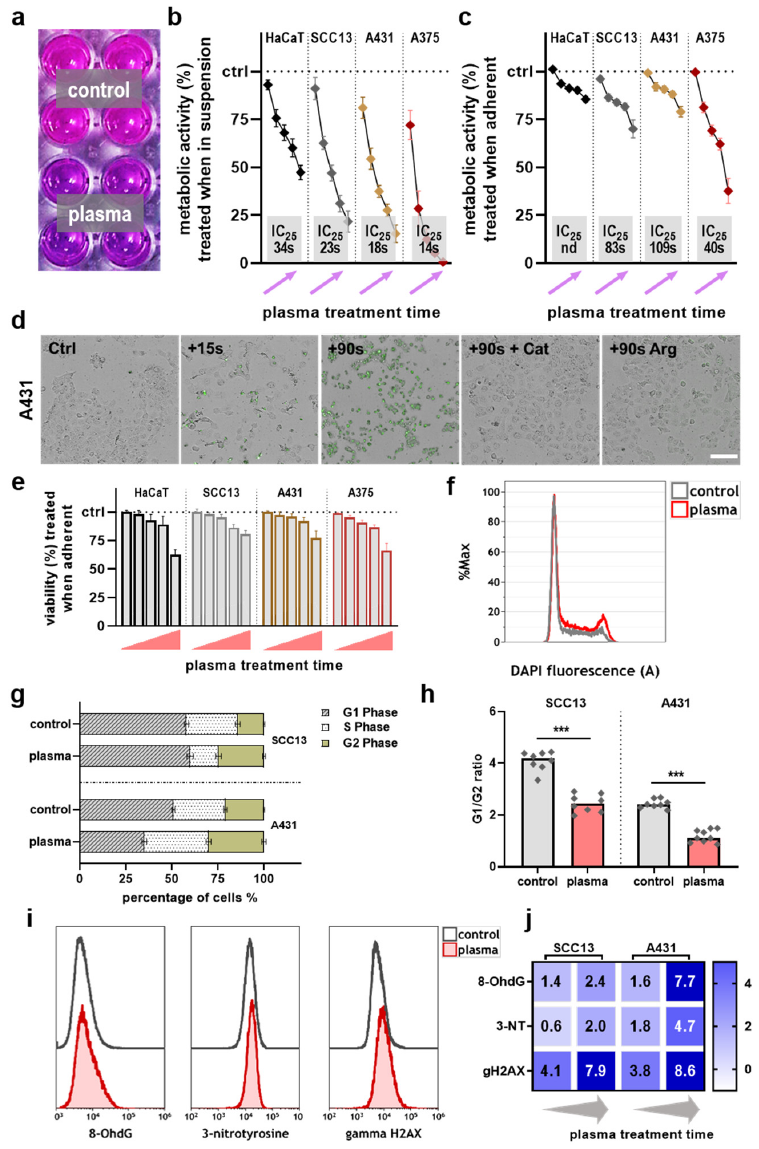
Figure 1. Gas plasma treatment in vitro: ( a ) image of the metabolic activity assay with higher (control) and lower (bottom) resazurin transformation, respectively; ( b , c ) quantitative analysis of gas